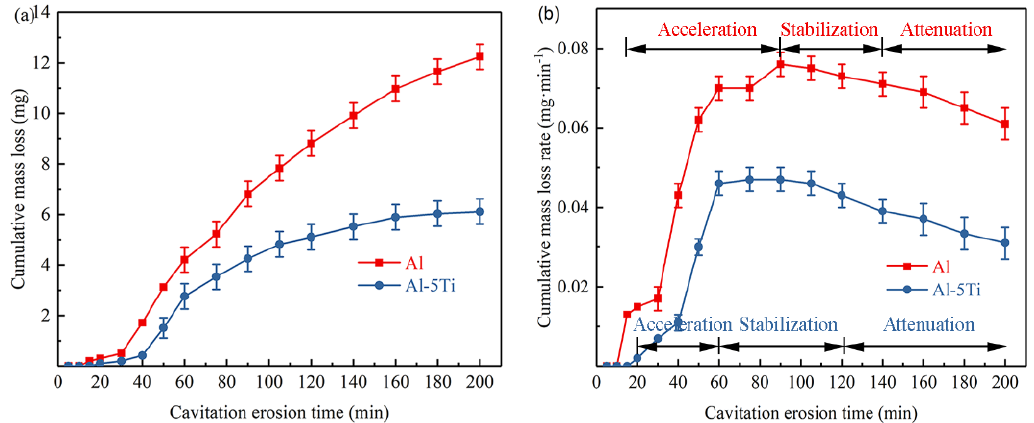
Figure 2. The cumulative mass loss graphs ( a ) and the cumulative mass loss rate graphs ( b ) in distilled water.